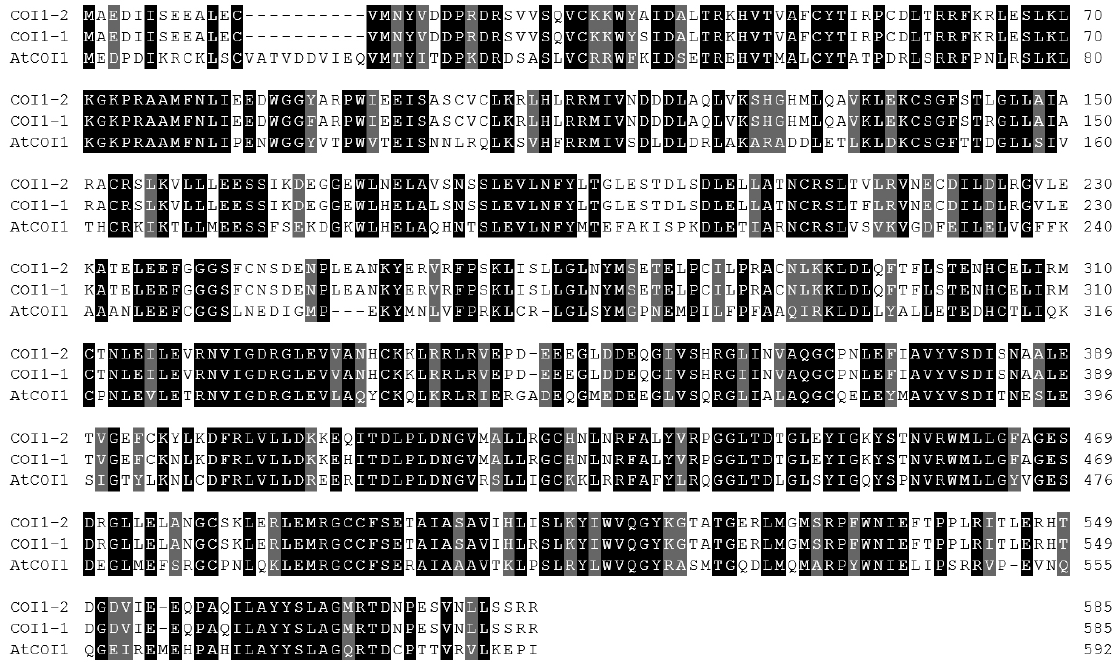
Figure A2. Results of the alignment analysis of Taxus COI1 and AtCOI1.